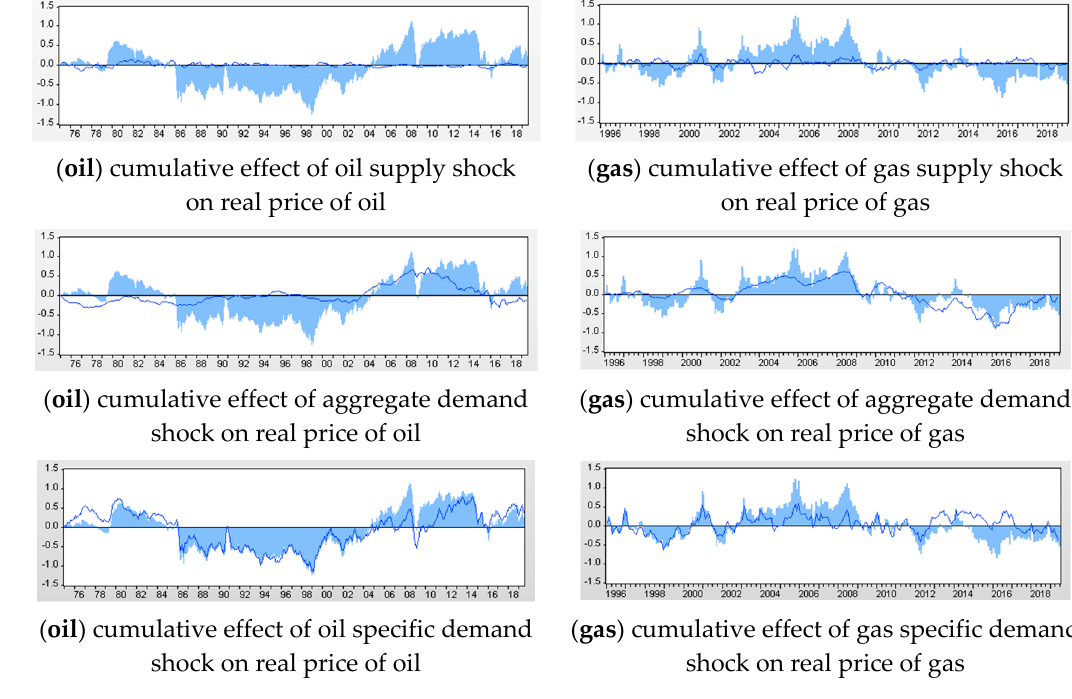
Figure 3. Historical decomposition of the real prices of crude oil and natural gas. From top to bottom, ( oil ) illustrates the cumulative effect of oil supply, aggregate demand, and oil market-specific demand shocks on the real price of crude oil. From top to bottom, ( gas ) illustrates the cumulative effect of gas supply, aggregate demand, and gas market-specific demand shocks on the real price of natural gas. Note: Estimates derived from Equations (1)–(4).